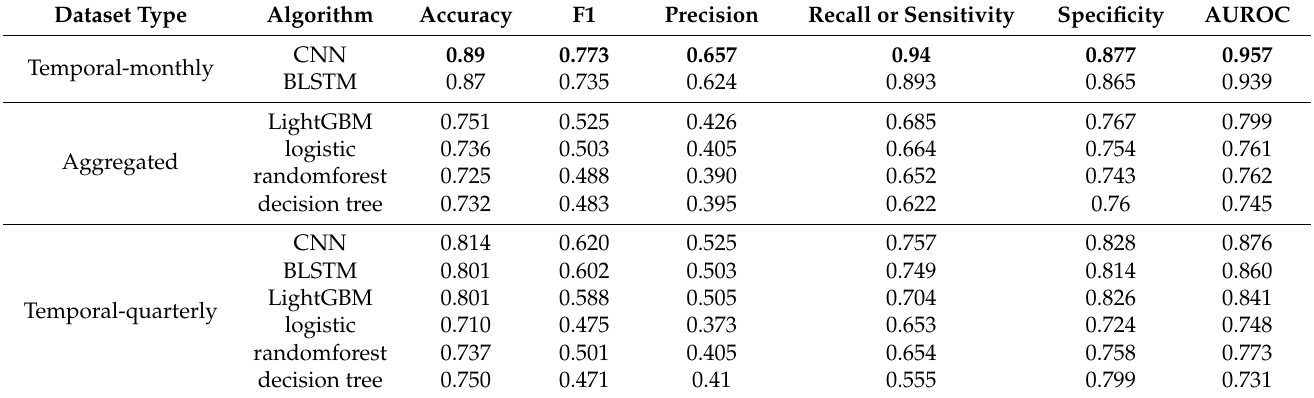
Table 3. Performance metrics for 6-month data.